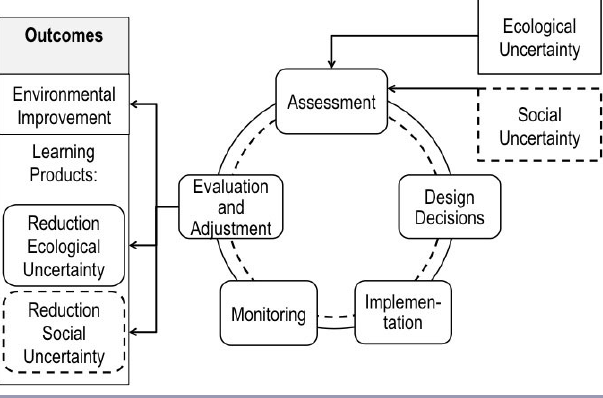
Fig. 2 . Success in adaptive management projects in relation to ecological and social